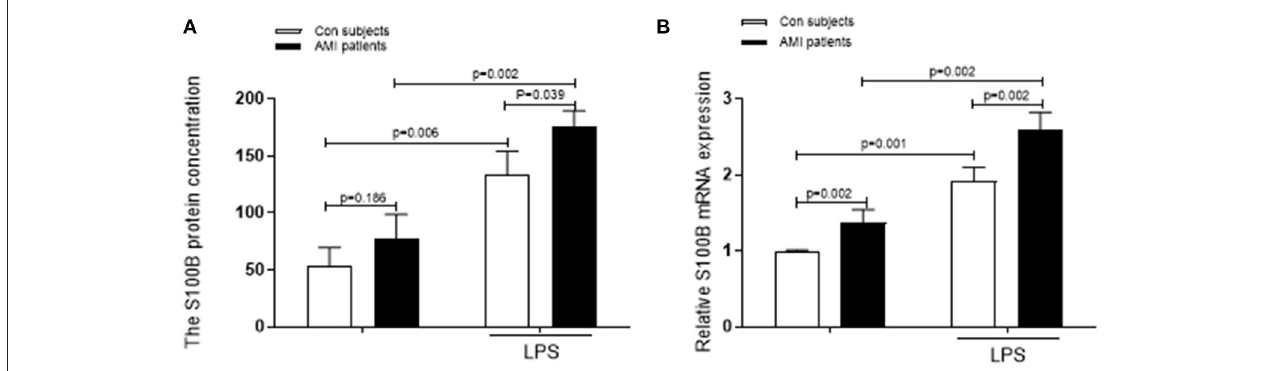
FIGURE 2 | Levels of S100B secreted by stimulated neutrophils are increased in AMI patients. (A) A comparision of the fold change in the levels secreted by LPS-stimulated neutrophils with that in unstimulated neutrophils from the same AMI patients ( n = 10) and control subjects ( n = 10). (B) The S100B mRNA levels and the corresponding secreted S100B levels in the unstimulated controls and LPS-stimulated subjects are